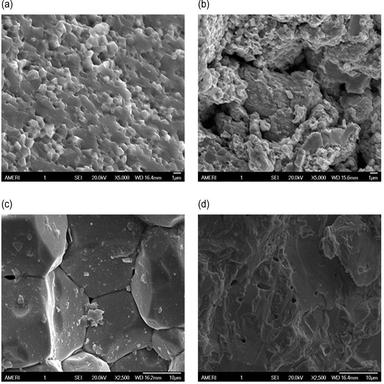
Ta10W and YSZ sides of TY-3-2 and TY-6-1. (a)YSZ in TY-3-2, (b) Ta10W in TY-3-2, (c)YSZ in TY-6-1, (d)Ta10W in TY-6-1.